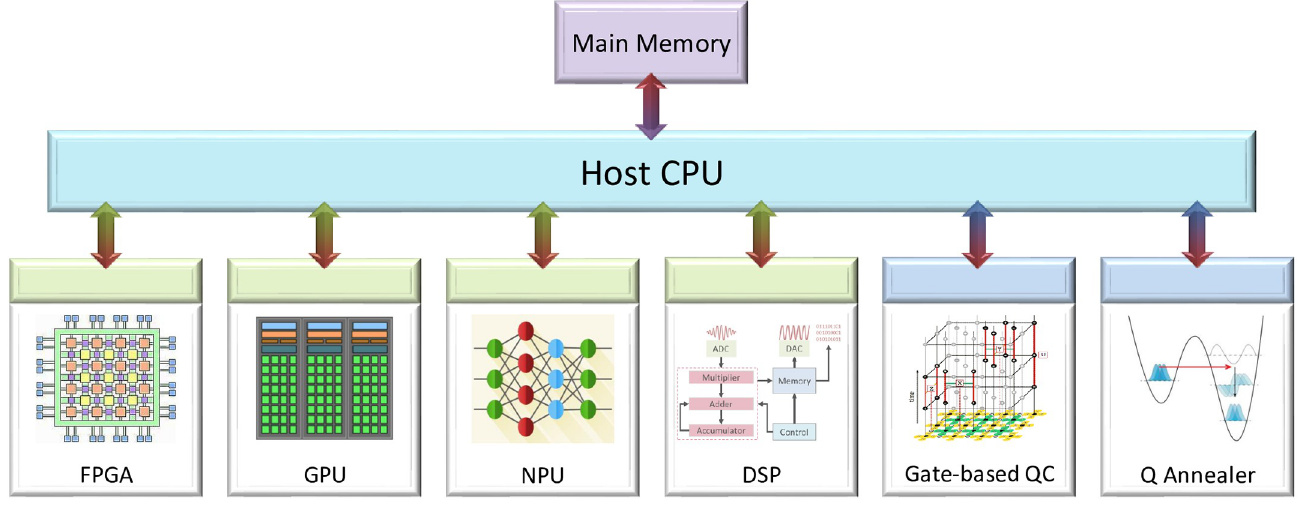
Fig 1. The accelerator model of